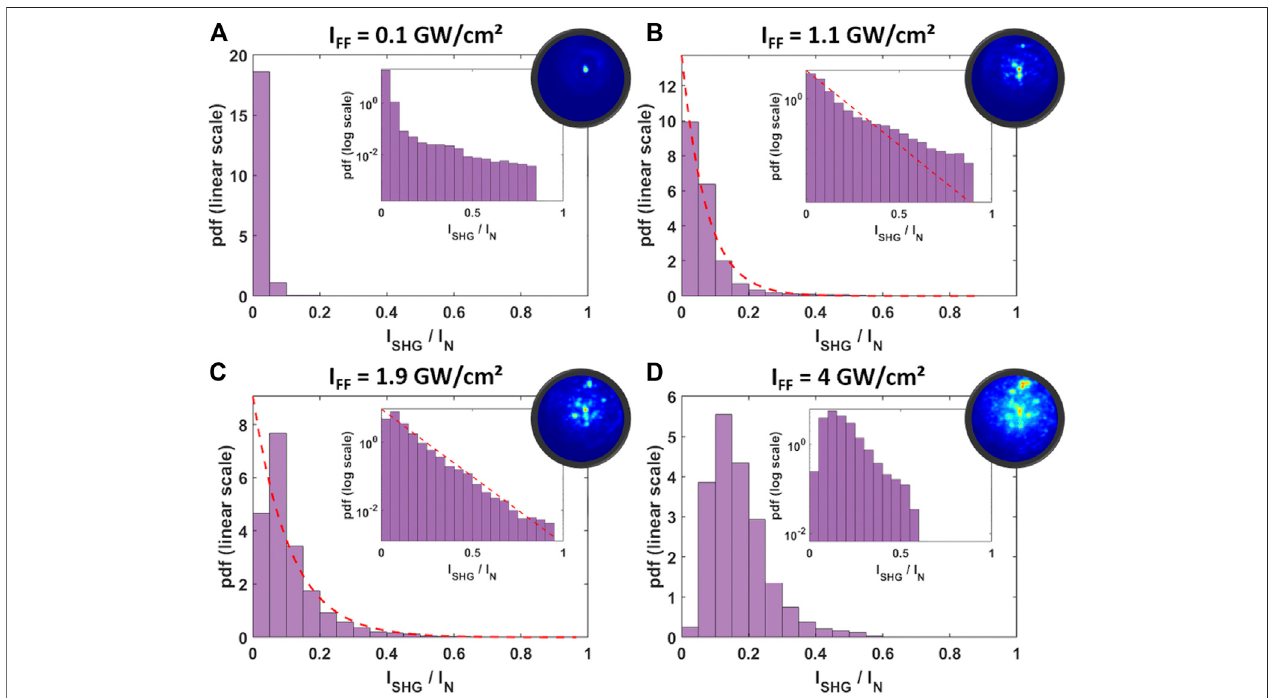
FIGURE3| StatisticsoftheSHintensitylevels, obtainedinKTPfordifferentinputpumpintensitiesI FF .InthehistogramstheintensityaxisoftheSHisnormalized to the maximum level permitted by the 8-bit camera. Note that the SH beam intensity was reduced by a variable attenuation to avoid saturation of the camera. The attenuation was modi fi ed for each value of I FF (A , B) . The circular insets are extracted from the corresponding cases of Figure 2 . The red dashed curves represent the applications of Eq.2 for the different cases.